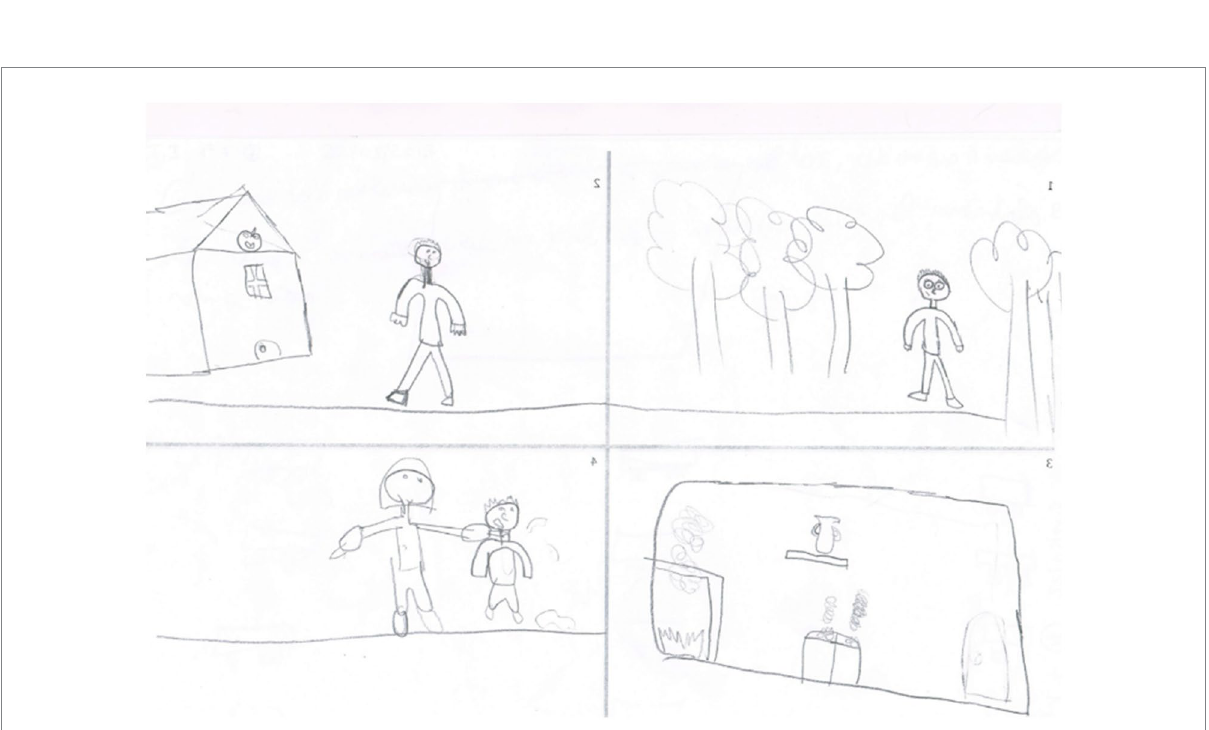
FIGURE 3 Negative outcome (NO) example: “ There is a child that is walking in the woods. He sees an house, due to his curiosity enters in that but he’s been killed by a man who’s hiding there. ” Male, 10 years